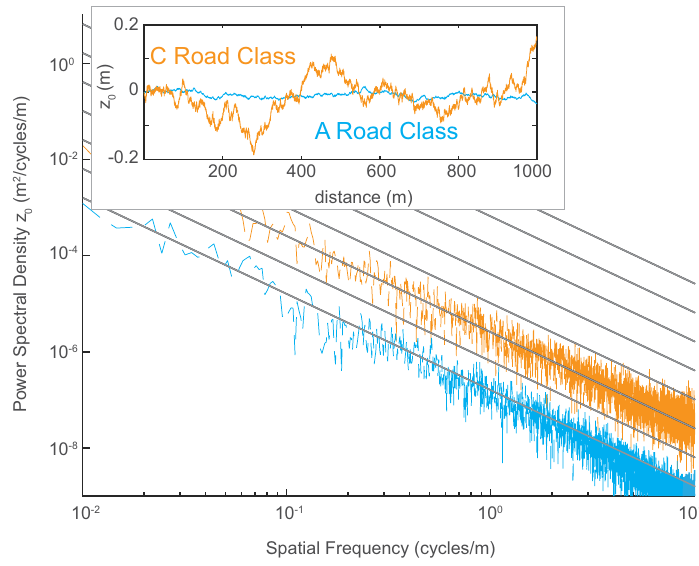
Figure 6. PSD for roads of different class according to [62]. Figure adapted by the authors from